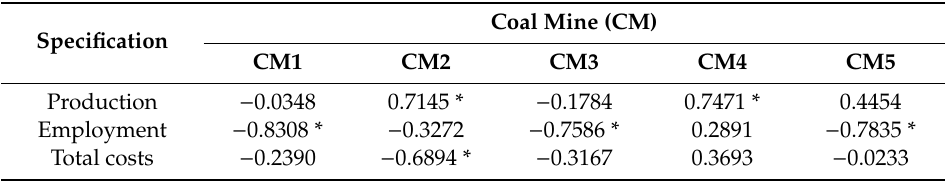
Table 2. Pearson linear coe ffi cients ( r xy ) between labor productivity and production volume, employment and total costs.